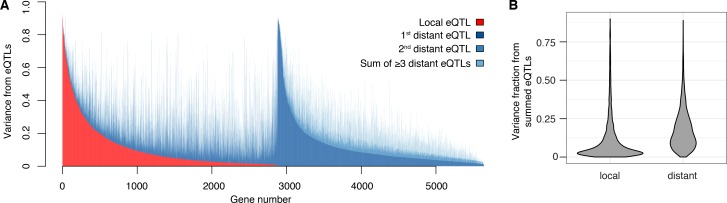
Contribution of local and distant eQTLs to expression variance.(A) A stacked barplot showing for each gene with at least one eQTL the amount of phenotypic variance from local and distant eQTLs. Genes are sorted first by the amount of variance from the local eQTL, followed by the amount of variance from the strongest distant eQTL. (B) Violin plots of the distributions of fractions of phenotypic variance explained by summed local and distant eQTLs, respectively. This panel was generated using genes with at least one local and one distant eQTL.